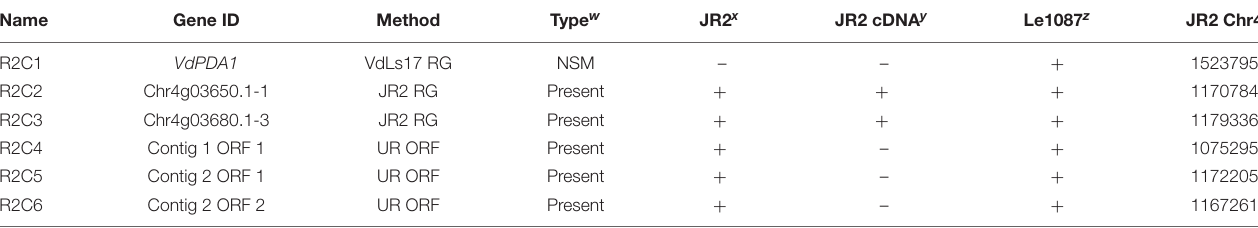
w Indicates how this gene is different between race 2 and race 3 isolates. NSM = gene present in both races but contains an NSM present only in race 2 but not in race 3. Present = gene and surrounding contig are only present in race 2 isolates, or race 1 isolates with no known race 2 phenotype (Le1087 or JR2) and are not present in